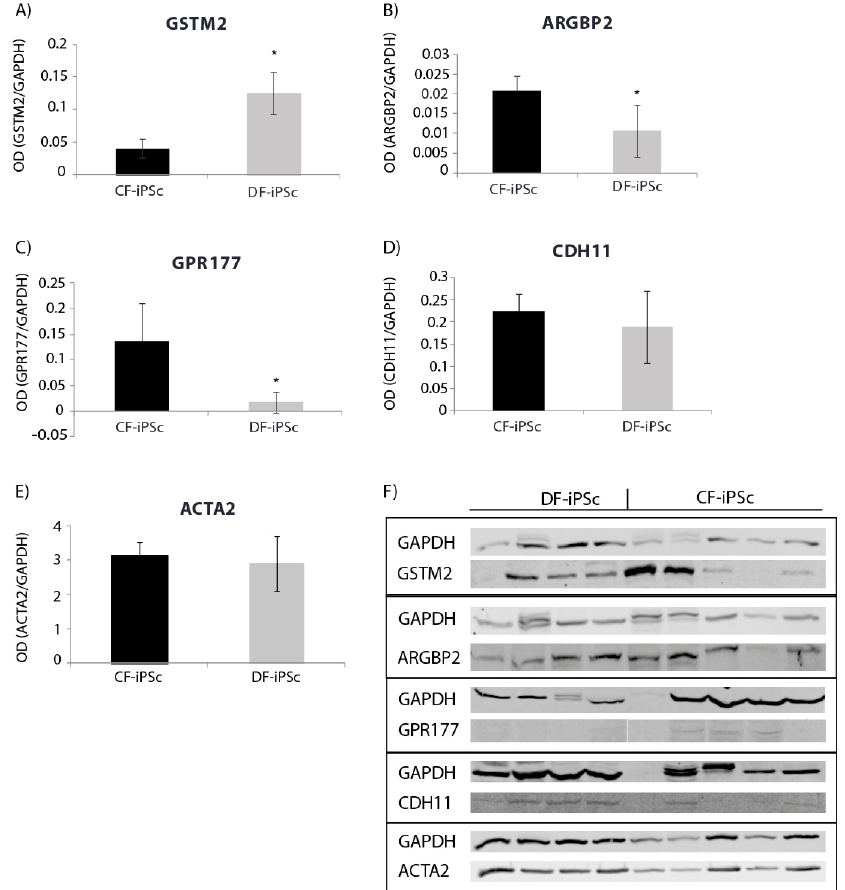
Figure 4. Western blot for iPSC protein (p16–18). ( A ) GSTM2 * p < 0.05. ( B ) ARGBP2 * p < 0.05. ( C ) GPR177 * p < 0.05. ( D ) CDH11. ( E ) ACTA2. ( F ) Blotting: CF-iPSC ( n = 4), CF-iPSC ( n = 5).